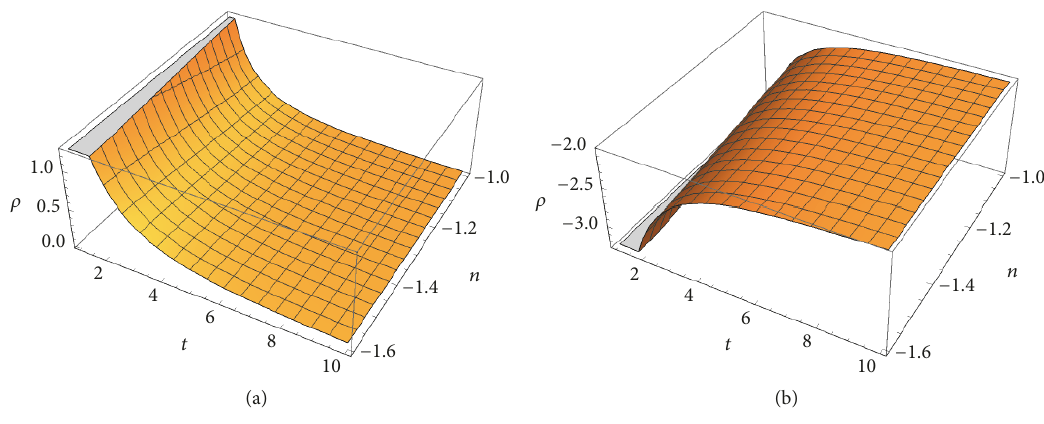
Figure 2: Behaviour of 𝜌 for dust